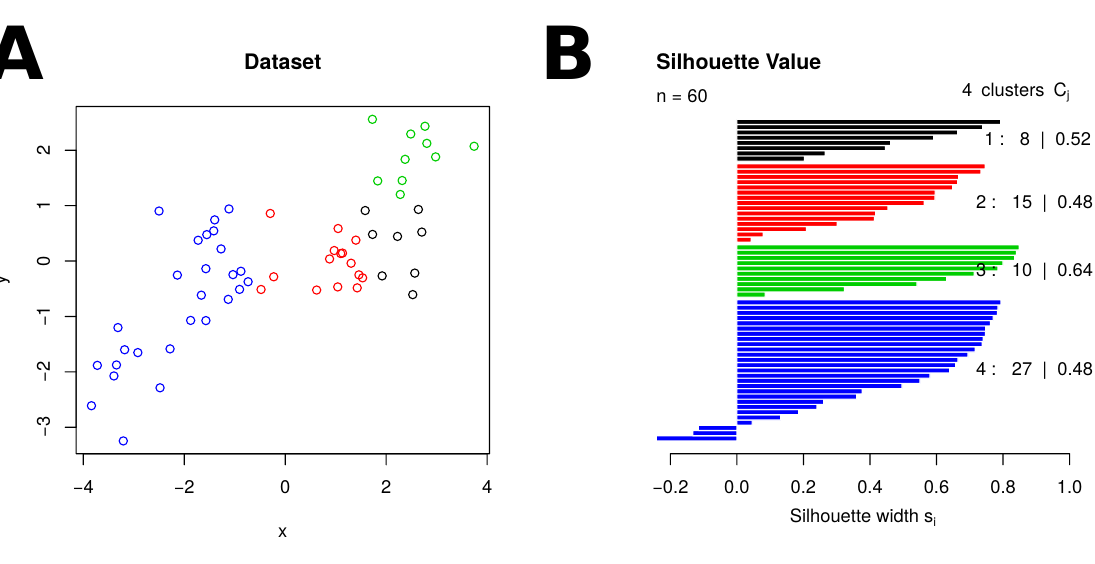
Figure 3: (A) clustering of a toy dataset with 60 objects. The colors of the objects represent the clusters. (B) depicts a typical silhouette plot of the clustering. The objects of each cluster get sorted by their silhouette value and plotted vertically. Negative silhouette values indicate that the object is on average closer to the points of the nearest other cluster than to the objects in its own